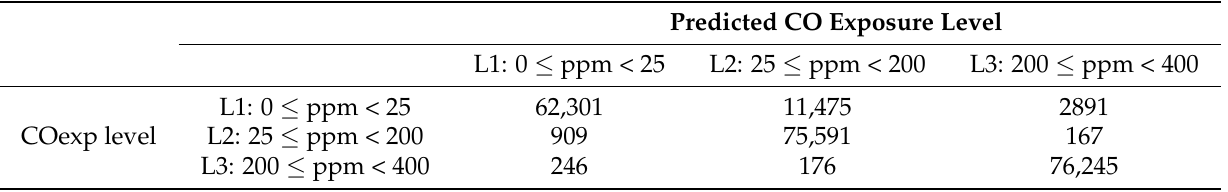
Table 2. Confusion matrix of CO exposure level classification using HR from the three FFs under